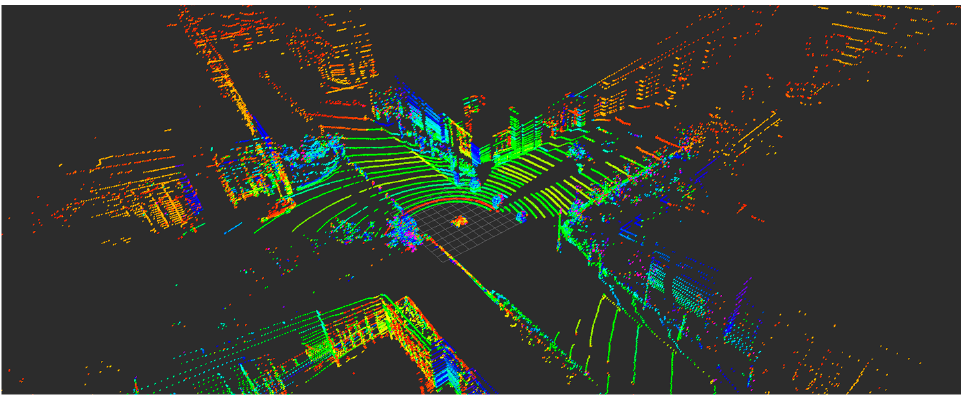
Figure 3. A cloud image of a vehicle approaching, an intersection illustrates the complexity of data collected by a LiDAR.